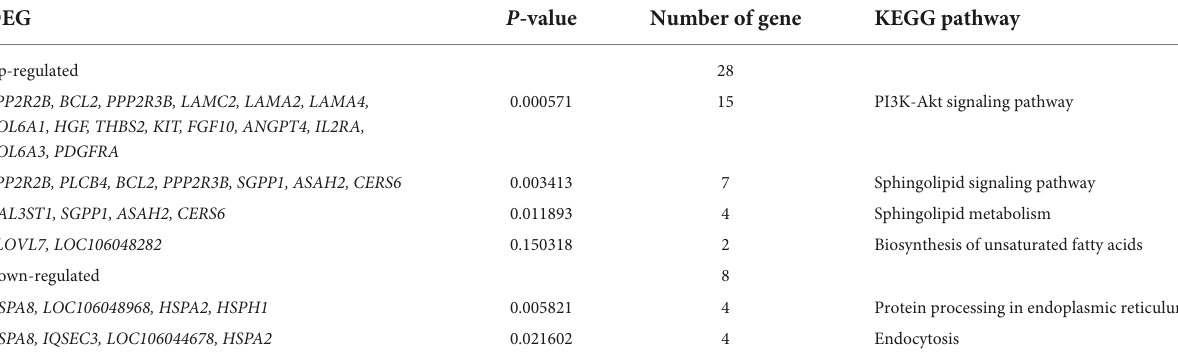
TABLE 8 Enrichment analysis of differentially expressed genes (DEGs) identified between groups C and W of Landes geese on day 90 based on the Kyoto Encyclopedia of Genes and Genomes (KEGG) database. DEG P -value Number of gene KEGG pathway